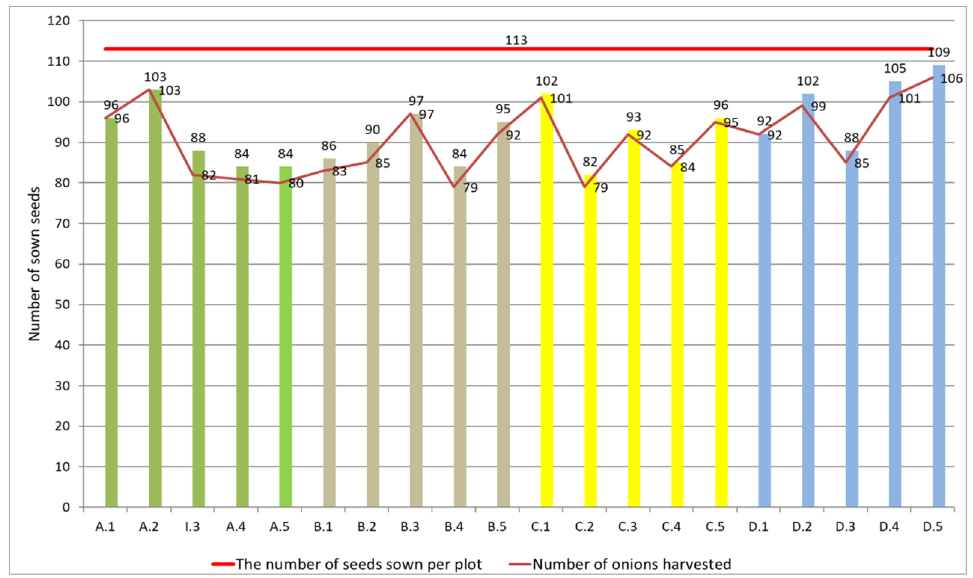
Figure 7. Number of onion seedlings (11 May 2016) and the number of harvested onions (02 September 2016) on individual plots for all weeding methods.